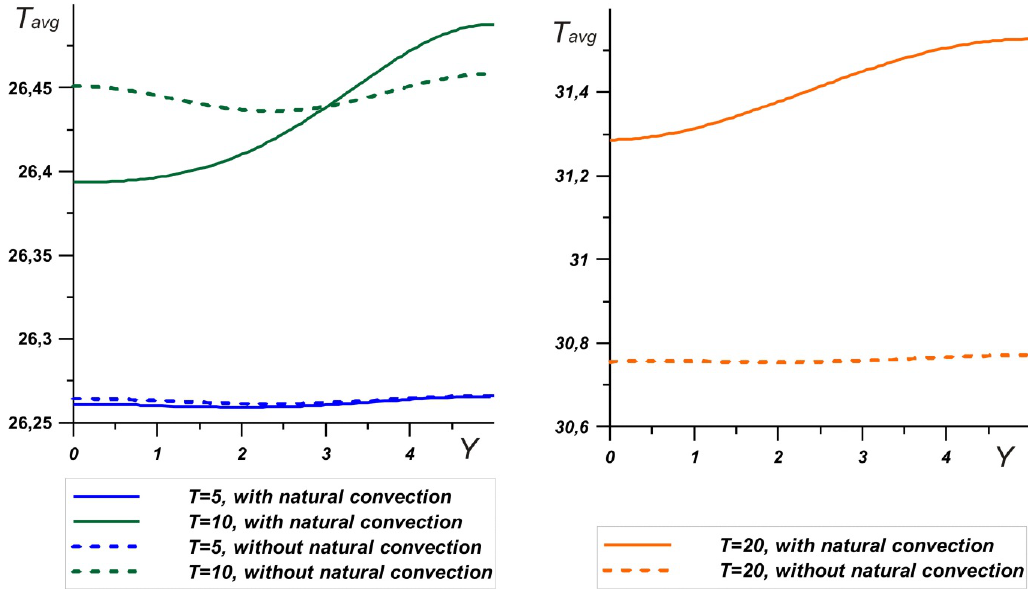
Figure 5. Temperature profiles on the right wall at L = 0.01m.